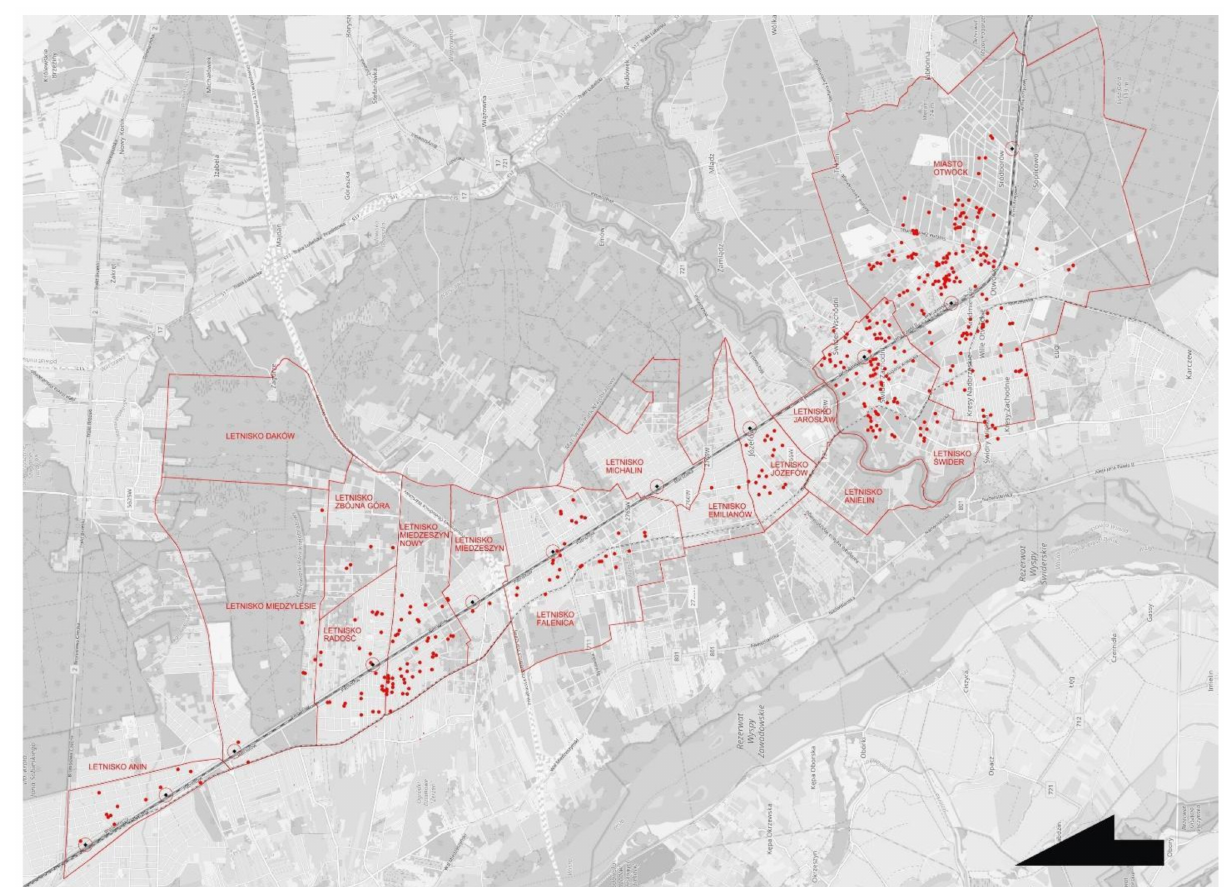
Figure 4. Historical boundaries of summer resorts (red line) with the location of wooden buildings (414) identified during the survey (red dots) on the “’Otwock Line” together with the marking of railway stations. The distribution of buildings has a clear linear character stretching along the railway line; graphic by M. G ó rski, based on